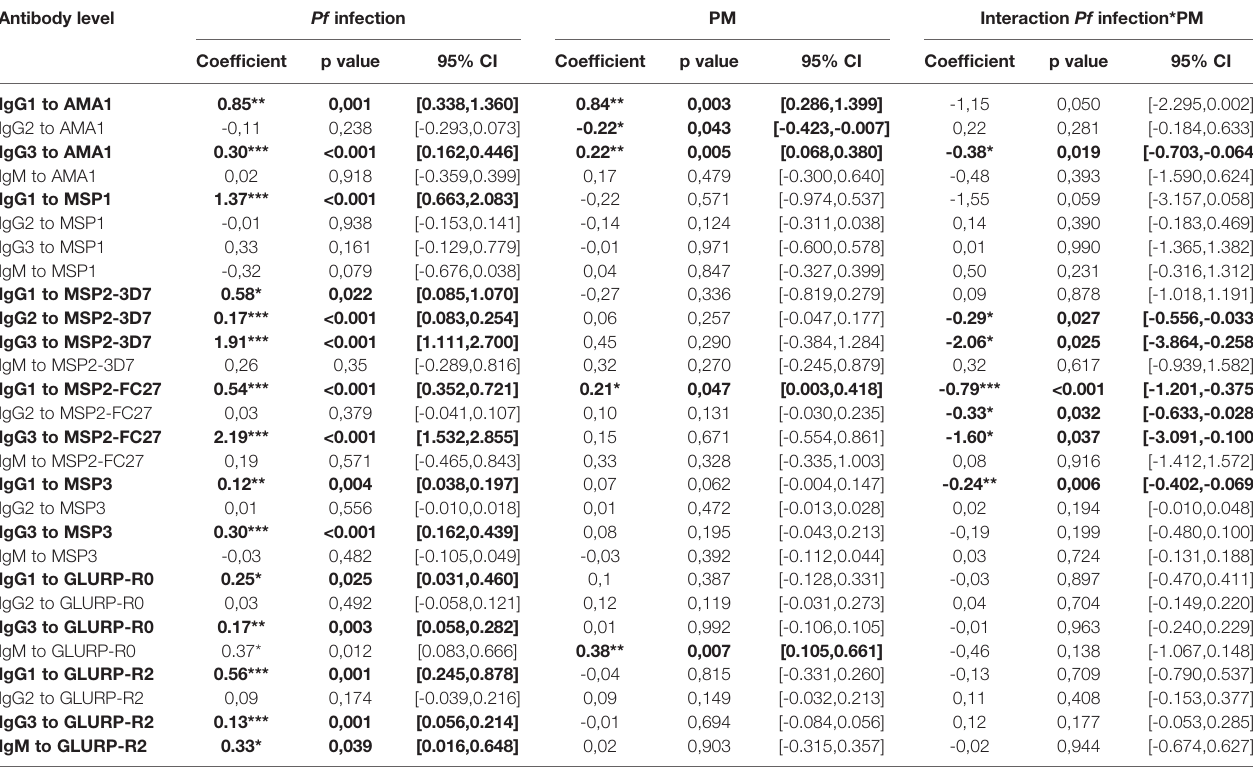
TABLE 5 | | Lower levels of cytophilic IgG to malaria antigens in infant born to women with PM and during active malaria. Antibody level Pf infection